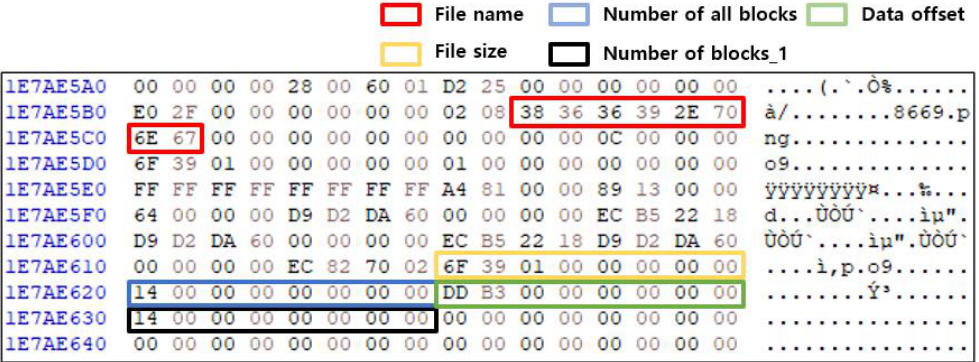
Figure 16. File record representing metadata where the 8669.png file is stored.